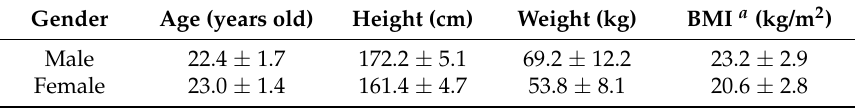
Table 1. Anthropometric information of